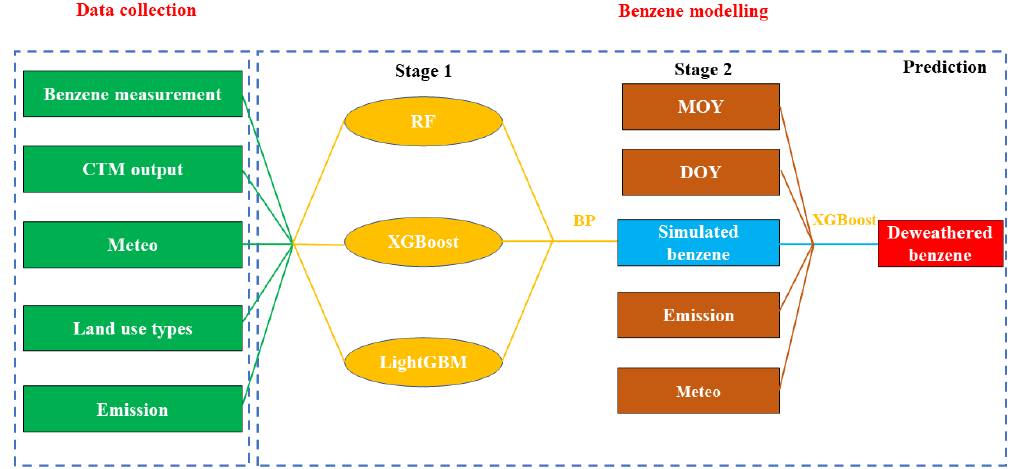
Figure 1. The workflow of global atmospheric benzene modelling. CTM output represents the simulated benzene concentration based on the GEOS-Chem model. Meteo denotes the meteorological parameters derived from GEOS-CF reanalysis. Emission represents the daily emissions of benzene. MOY and DOY are the month of year and day of year, respectively. Simulated benzene represents the predicted benzene concentrations based on the ensemble model. Deweathered benzene denotes the benzene concentration after removing meteorological